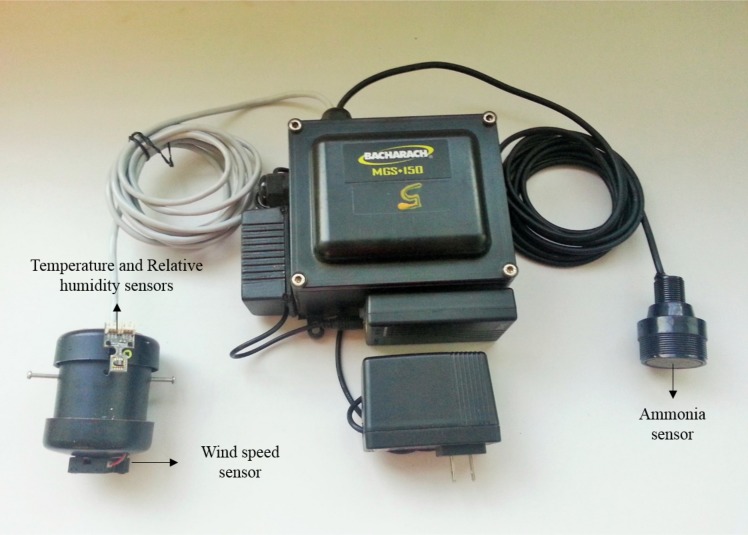
Measuring equipment (sensor node) used during the study.